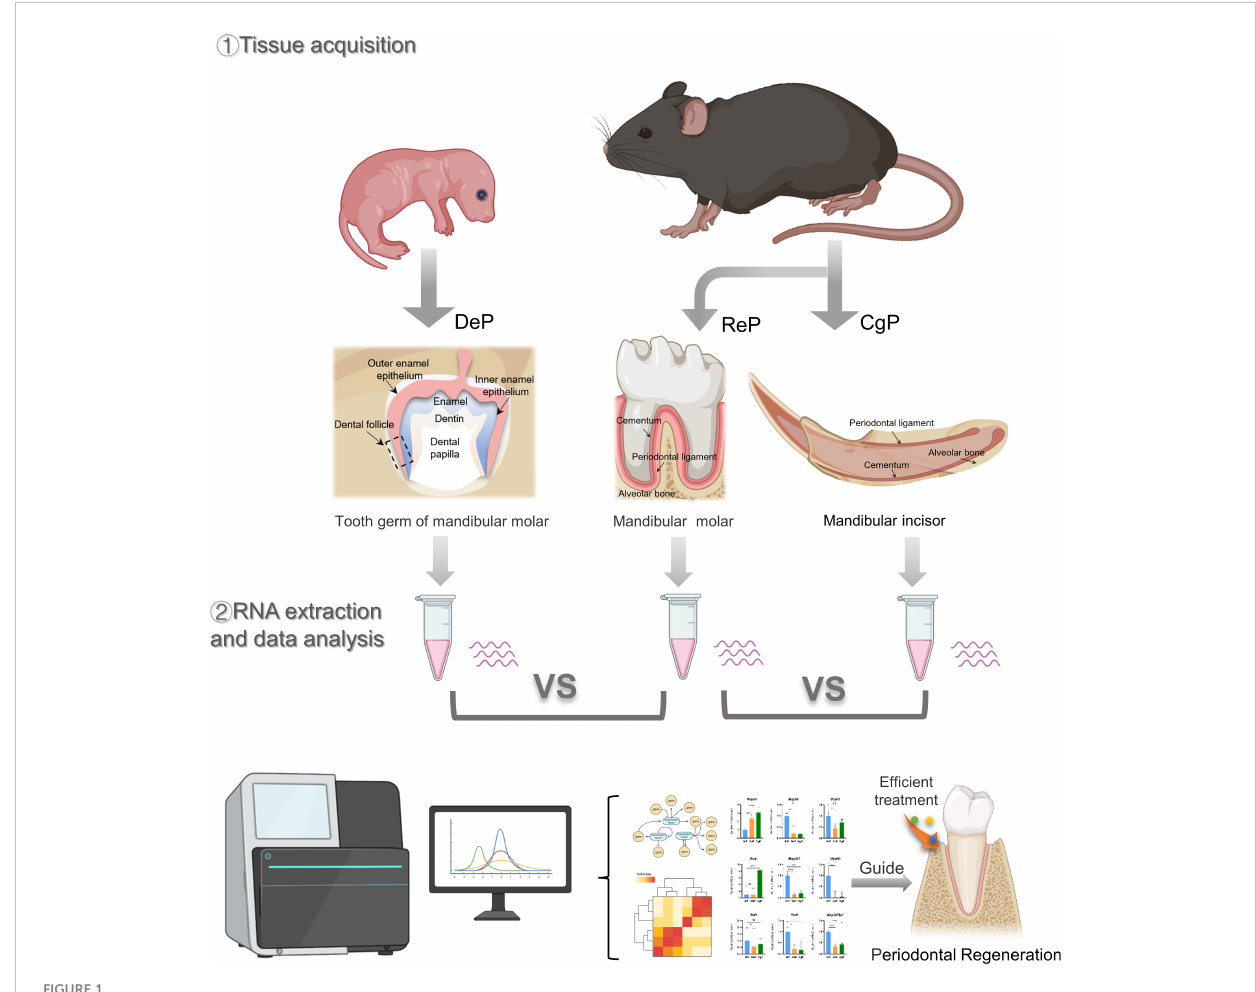
FIGURE 1 Schematic representation of the